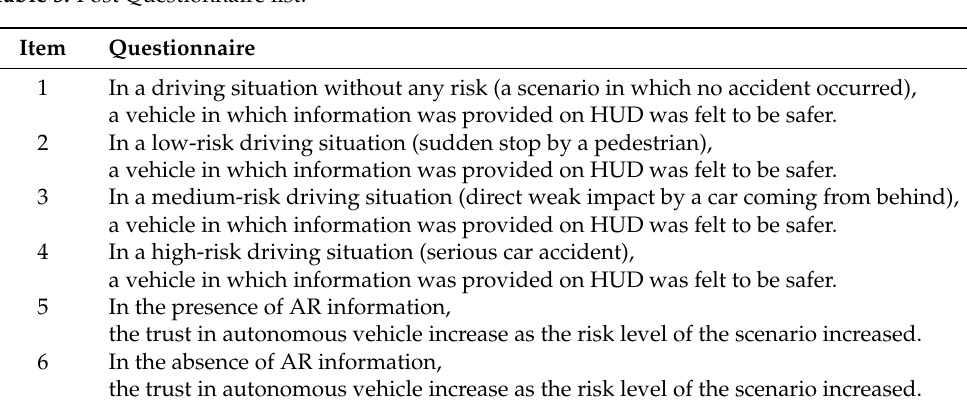
Table 5. Post Questionnaire